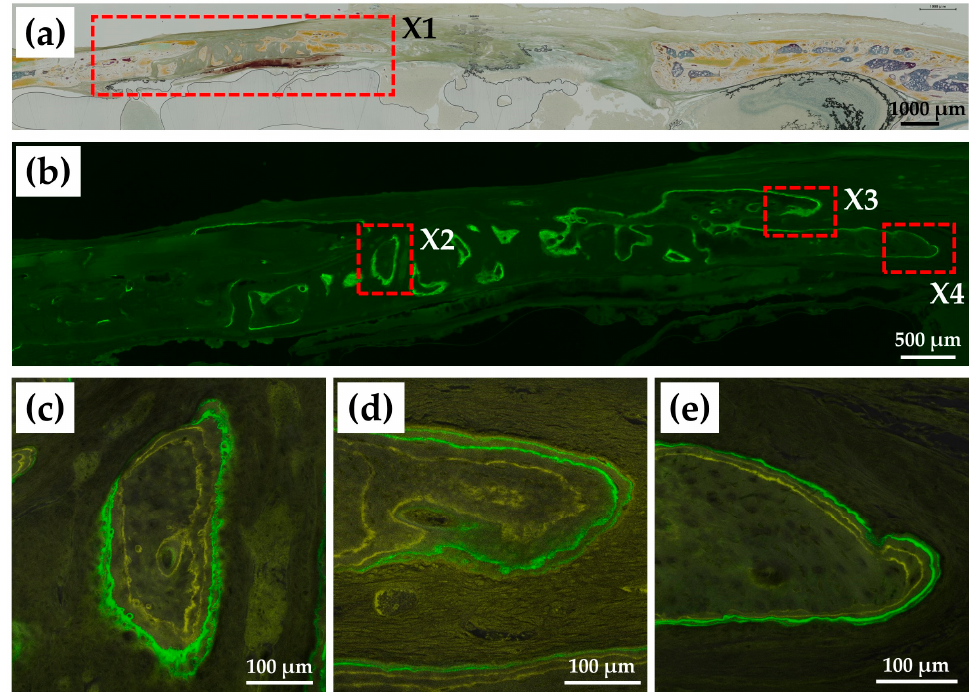
Figure 11. ( a ) Villanueva-stained image of a rat cranial bone defect 8 weeks after implantation of BMP (+) construct (i.e., cHLA/cAG/nHAp/BMP), ( b ) magnified calcein (CL)-fluorescent image of X1 in ( a ), ( c ) magnified tetracyclin (TC)–CL-dual fluorescent image of X2 in ( b ), ( d ) magnified TC–CL-dual fluorescent image of X3 in ( b ), ( e ) magnified TC–CL-dual fluorescent image of X4 in ( b ).